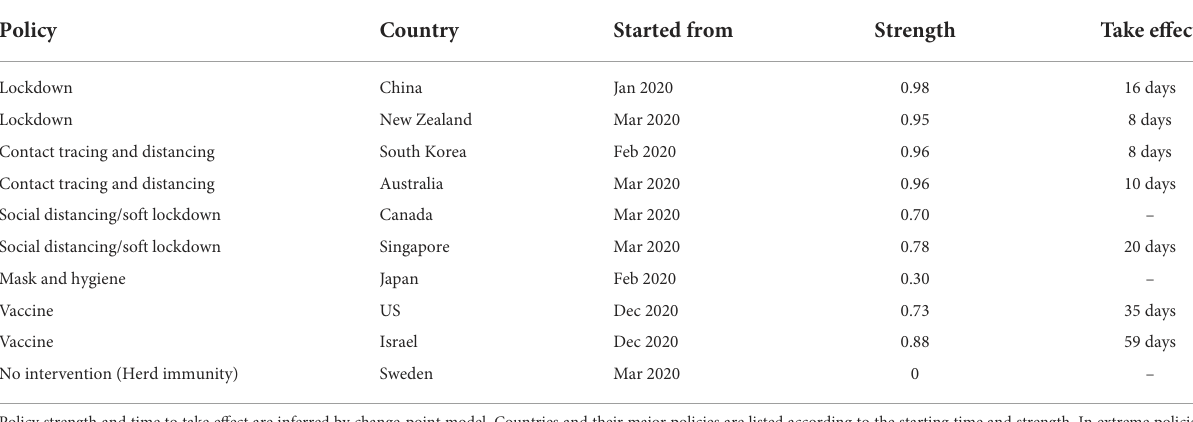
TABLE 2 Countries and policies used for analysis.